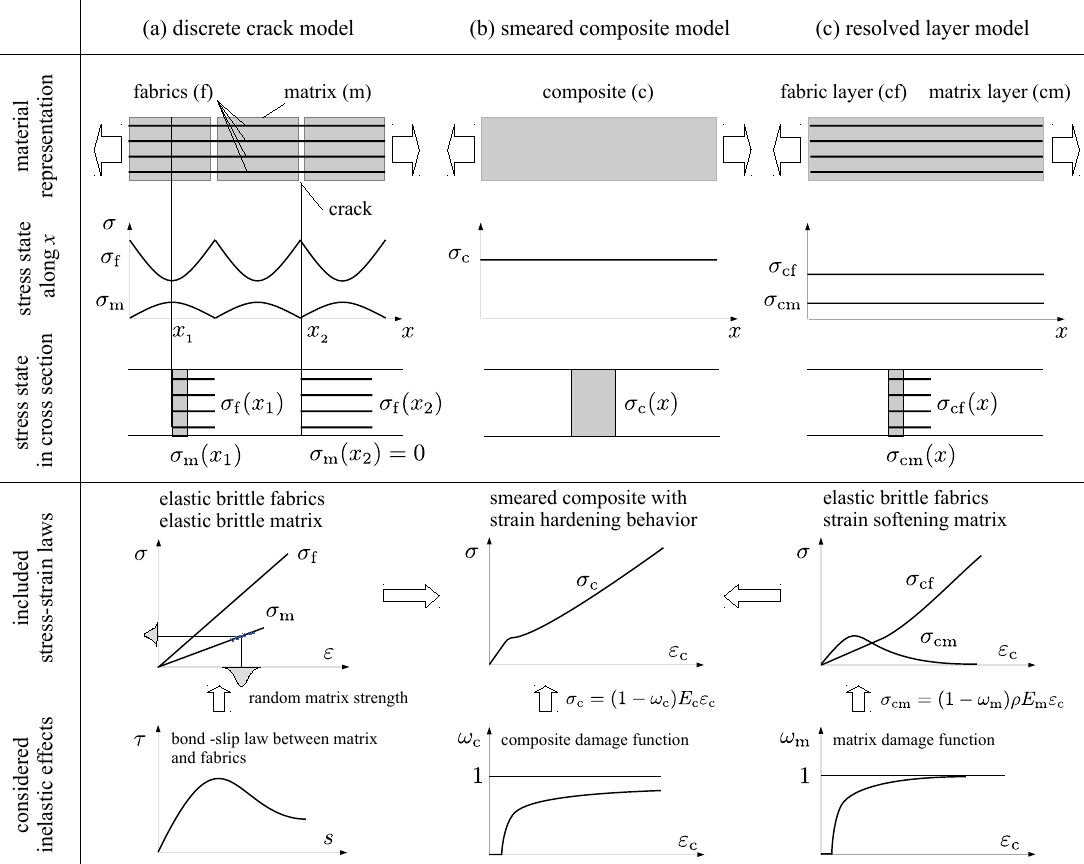
Figure 1. Classification of modeling approaches to tensile behavior of textile-reinforced concrete shells including the resolution of stresses along a uniaxial specimen, resolution of stress and strain components in a material point and examples of inelastic material